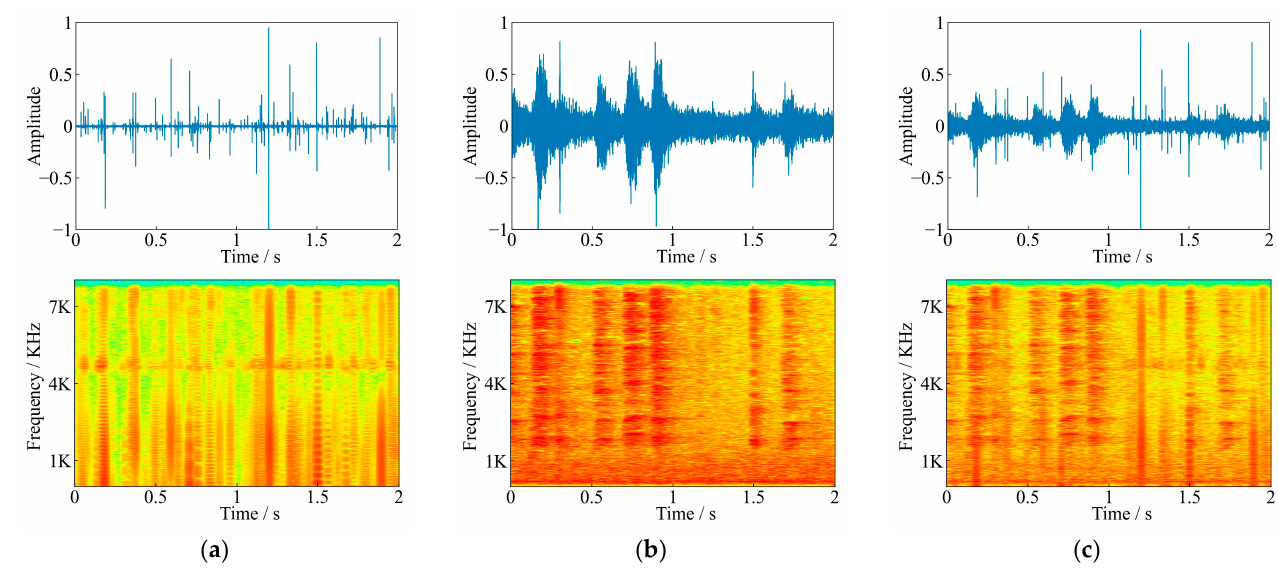
Figure 3. Comparison of waveforms and spectrograms before and after mixing ( a ) S. bifasciatus feeding sound, ( b ) noise audio containing bird songs, ( c ) mixed audio at − 5 dB SNR.